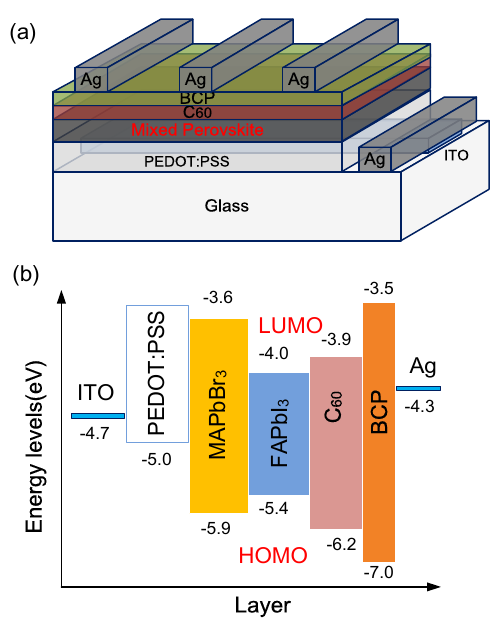
Figure 1. ( a ) Complete structure and ( b ) corresponding energy band diagram of the structure.